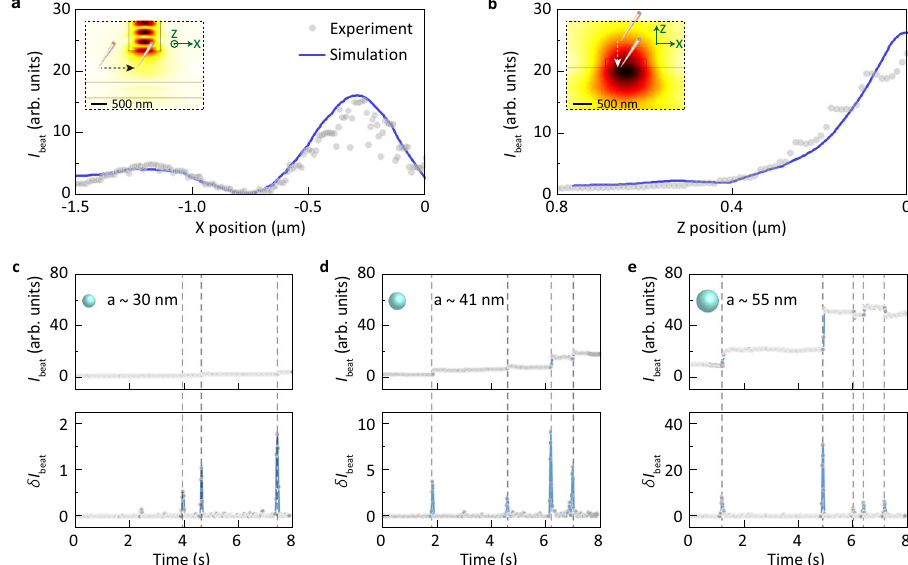
Fig. 2 Characterization of sensing performance. a – b Beat intensity I beat when a silica nanotip with the radius of 200 nm is horizontally and vertically scanned for 1.5 μ m ( a ) and 0.8 μ m ( b ), respectively. Insets, fi eld distributions of fundamental TE mode of a waveguide and near- fi eld scanning range of the nanotip. c – e Beat intensity I beat (top) and the corresponding δ I beat (bottom) when single polystyrene nanobeads with the radii of 30 nm ( c ), 41 nm ( d ), and 55 nm ( e ) are deposited at the joint sensing